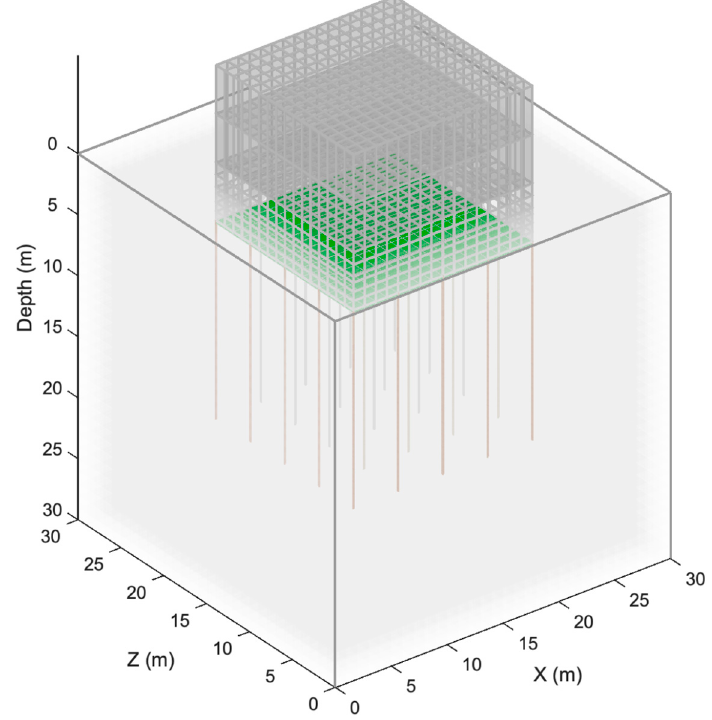
Figure 10. Soil-block with a 16 × 16 m 2 building with basement (of 5-m depth) on top. The soil, wall and roof panel elements are rendered in transparent fashion, so as to allow visualisation of the concrete base slab, represented in green colour, as well as of the timber piles, represented in brown colour. Table 1. Properties of the building with basement structural model (c: concrete, m: masonry, t: timber). Base Height of dimens. (m) superstr. (m)